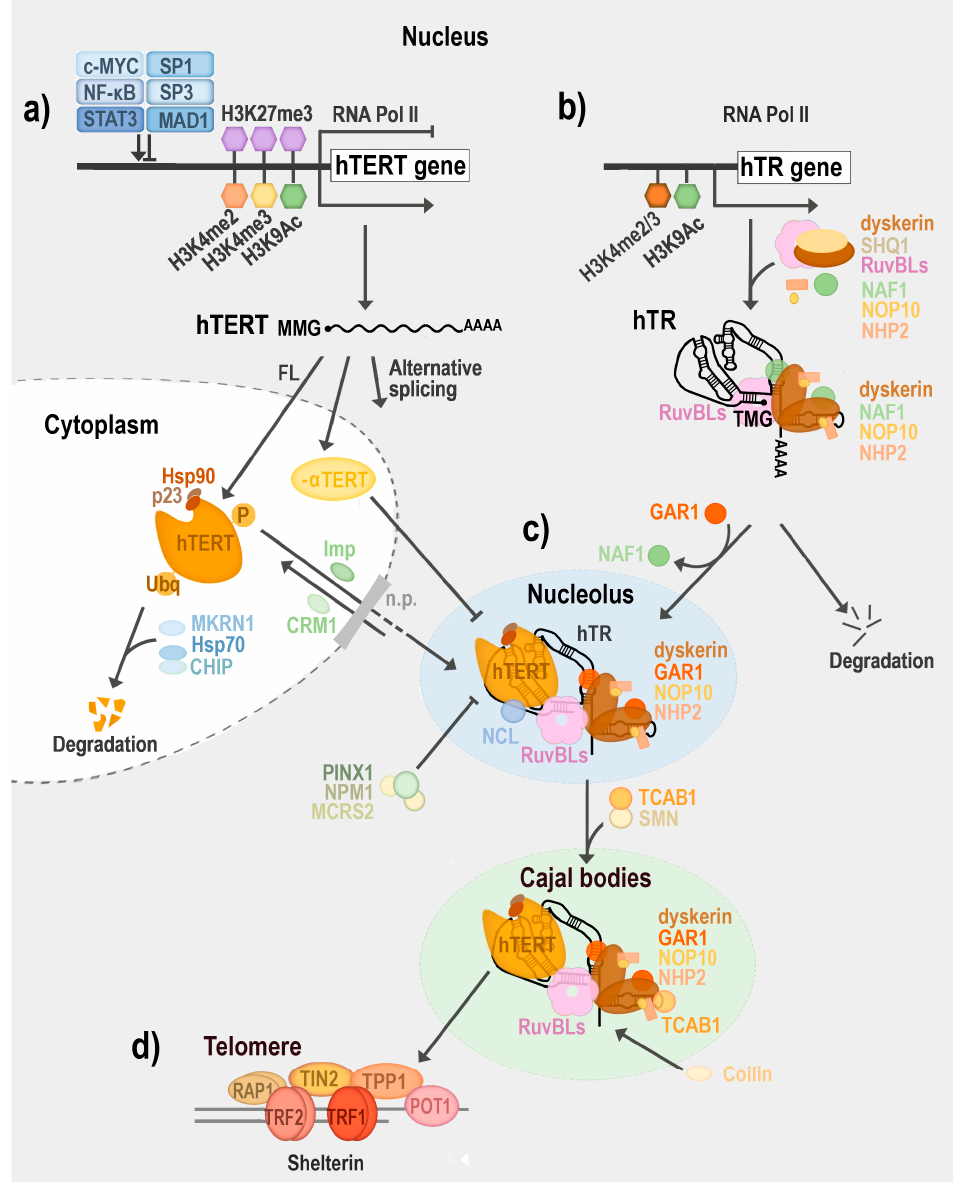
Figure 4. Regulation of human telomerase biogenesis. ( a ) Transcription of the human telomerase reverse transcriptase gene ( hTERT ) by RNA polymerase II (RNA Pol II) is regulated by several activators and repressors acting at the promoter level (e.g., c-MYC, Nuclear Factor κ B (NF- κ B), Signal Transducer and Activator of Transcription 3 (STAT3), Specificity Protein 1 / 3 (SP1 / 3), MAD1). Histone modification H3K27me3 often silences hTERT , however the mutated hTERT allele is marked by the active histone marks H3K4me2, H3K4me3 and H3K9ac. hTERT pre-mRNA with a 5 (cid:48) mono-methylguanosine (MMG) cap and poly(A) 3’ tail can be spliced into full-length (FL) or multiple alternative isoforms (Alternative splicing) that are catalytically inactive or even inhibit telomerase activity (e.g., minus alpha hTERT (- α hTERT) due to their competition for human TR (hTR) with FL hTERT). The binding of heat shock protein 90 (Hsp90) with its co-chaperone (p23) in the cytoplasm enables hTERT phosphorylation (P). hTERT is further imported back to the nucleus by Importin α or β 1 (Imp) via nuclear pores (n.p.), while the export of hTERT may be mediated by the chromosome region maintenance 1 protein homolog (CRM1, also known as exportin-1). The ubiquitin (Ubq)-proteasomal degradation of TERT is driven by E3 ubiquitin-protein ligase makorin-1 (MKRN1), heat shock protein 70 (Hsp70) and carboxyl-terminus of Hsp70 Interacting Protein (CHIP). ( b ) Histone modifications H3K4me2/3 or H3K9Ac help to regulate read-through of the human telomerase RNA (hTR) gene by RNA Pol II in telomerase-positive cell lines. SHQ1 chaperone and RuvB-like proteins (RuvBLs) facilitate the assembly of nascent RNA with RNA scaffold proteins (dyskerin, NOP10,